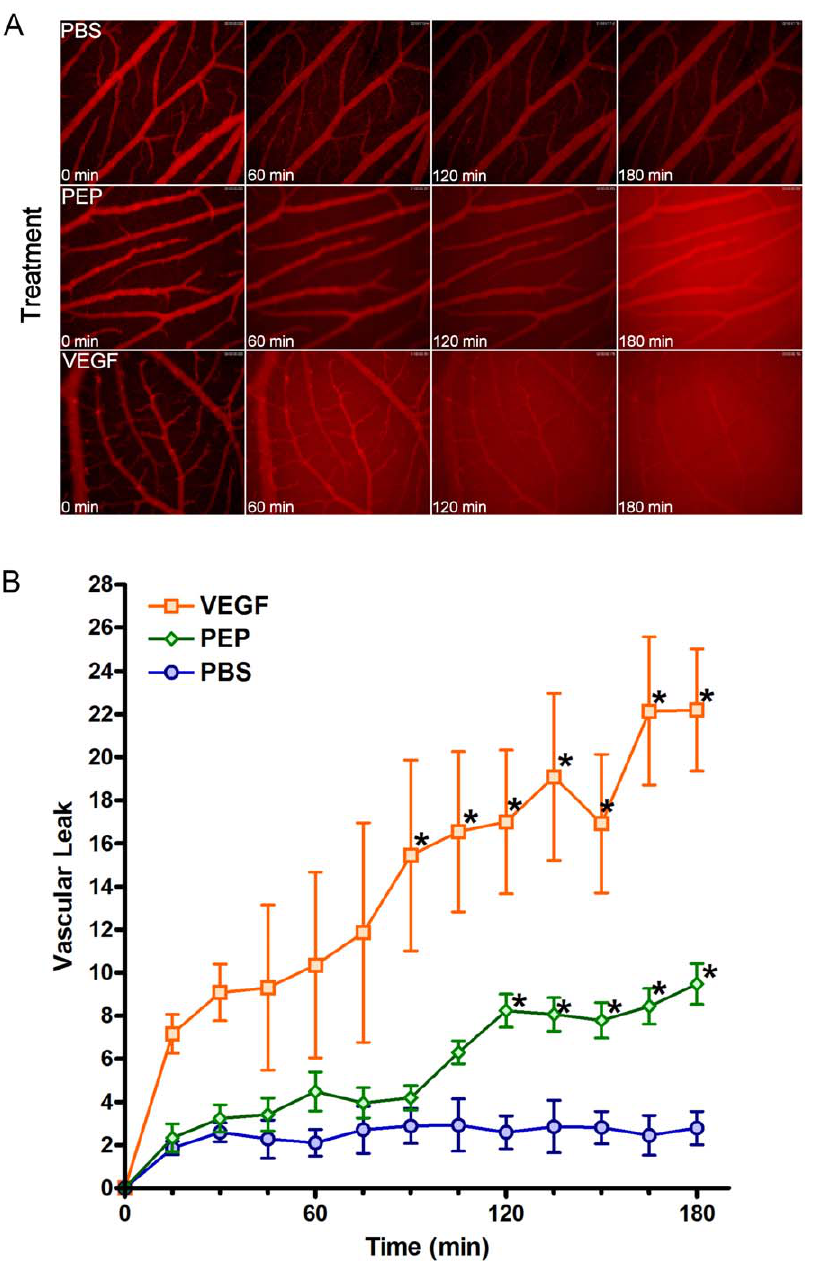
Figure 2. Intravital imaging assesses real-time changes in vascular permeability induced by VEGF and PEP. A. A series of representative images from intravital imaging experiments is shown. An accumulation of fluorescence outside the vasculature over time is seen in those embryos treated with VEGF or PEP compared to PBS. B. Images were captured and quantified every 15 minutes over a period of 3 hours to evaluate the extent of vascular leak. Vascular leak values were generated by subtracting time 0 values from subsequent time points. Asterisks indicate significant leak of dextran from the vasculature (2-way ANOVA, p , 0.05 followed by Bonferroni post-tests, (p , 0.05)) comparing either PBS vs VEGF, or PBS vs PEP at each time